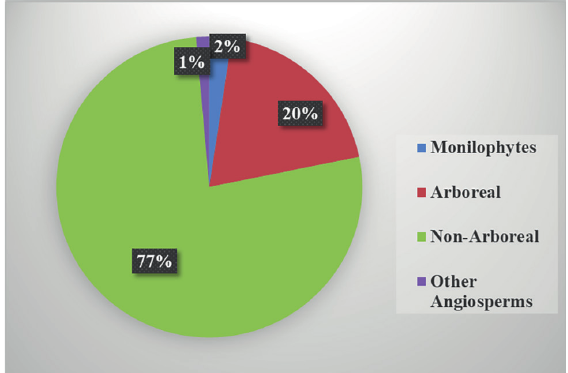
Figure 2. Percentage of palynomorphs recorded in the pollen rain in Itapuã State